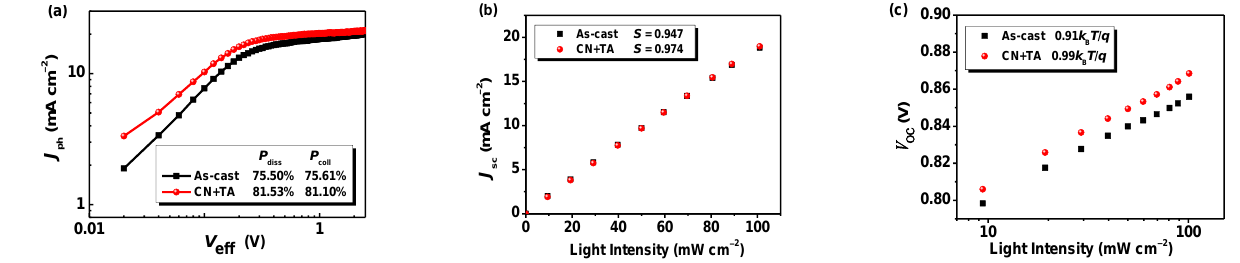
Figure 3. ( a ) J ph - V eff curves; ( b ) J sc - P light fitting lines; and ( c ) V oc - P light fitting lines of the PBDB-T: IDT-TNIC-based devices.